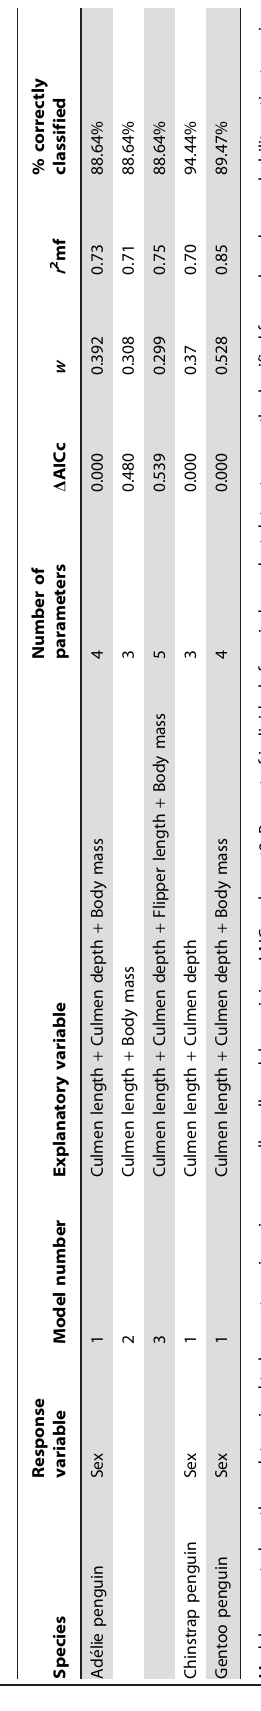
(Table 1). For gentoo penguins, the most parsimonious model accurately predicted sex for 34 out of 38 individuals (89.47%, Table 1). See Supporting Information Text S3 for details on probability estimates and misclassification. As expected, Pygoscelis penguin SDIs were larger for morpho- logical parameters that better predicted sex of adult penguins (Table 2). Negative SDI values indicate that for each structural parameter male Pygoscelis penguins were, on average, larger than females.